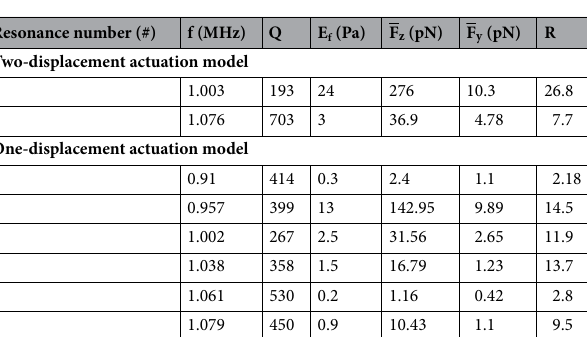
Figure 1. The acoustophoretic microfluidic system made of an aluminum microchannel used in this study. ( a ) Typical acoustophoretic device, ( b ) one-displacement actuation representing the one piezoelectric system, ( c ) two-displacement actuation representing the two piezoelectric system, ( d ) acoustic energy density of the fluid domain (blue curve) and the solid domain (red curve) in the two-displacement actuation. ( e ) is the same as ( d ) but for the one-displacement actuation, ( f ) average acoustic radiation force in the z direction (blue curve) and the y direction (red curve) in the two-displacement actuation. ( g ) is the same as ( f ) but for the one-displacement actuation.